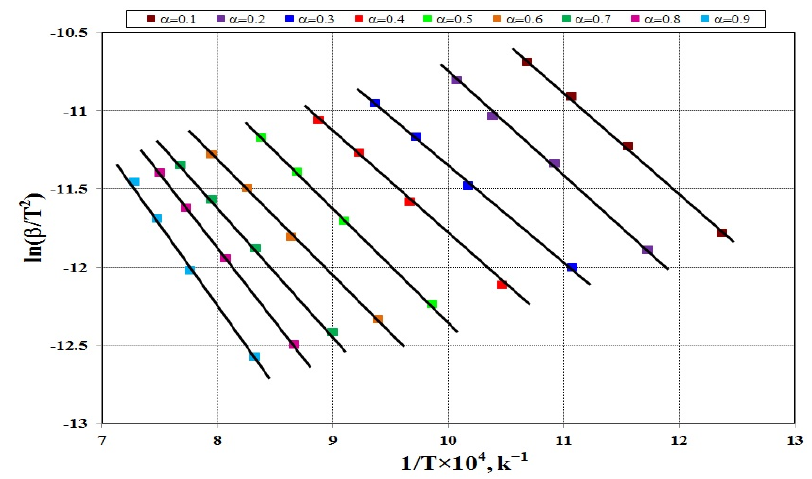
Figure 10. Calculated Ea against conversion degree for Fe 2 O 3 /coal.